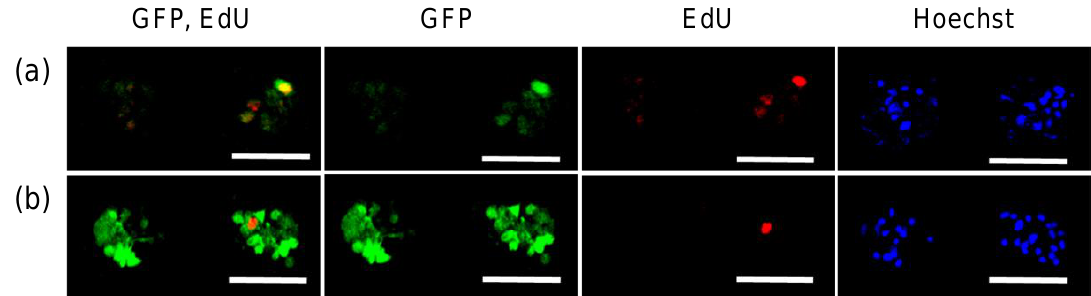
Figure 2. Relation between GFP expression and cell division in MSC spheroids. GFP pDNA ( a ) and GFP mRNA ( b ) were added to MSC spheroids, followed by 24 h incubation with EdU. Then, cells were observed with confocal laser scanning microscopy. Green: GFP (immunostaining), Red: EdU, Blue: cell nuclei (Hoechst 33342). Scale bars: 100 μm. Table 1. Percentage of GFP-positive cells in MSC spheroids.